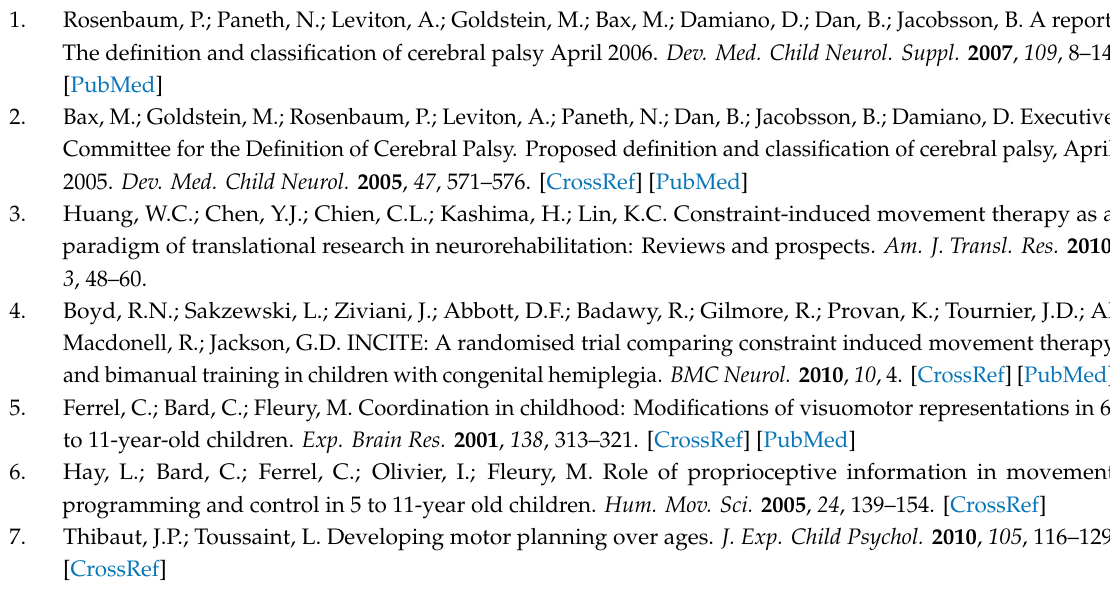
Intervention Weeks for Both Groups (mCIMT and UTWC)